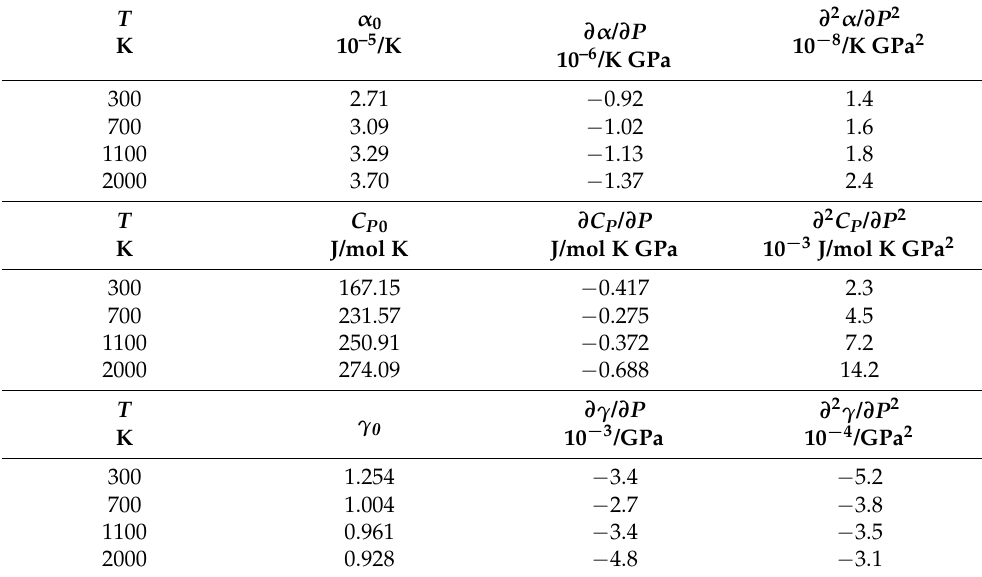
Table 3. The thermal expansion, heat capacity, and Grüneisen parameters of diopside and their first and second derivatives with respect to